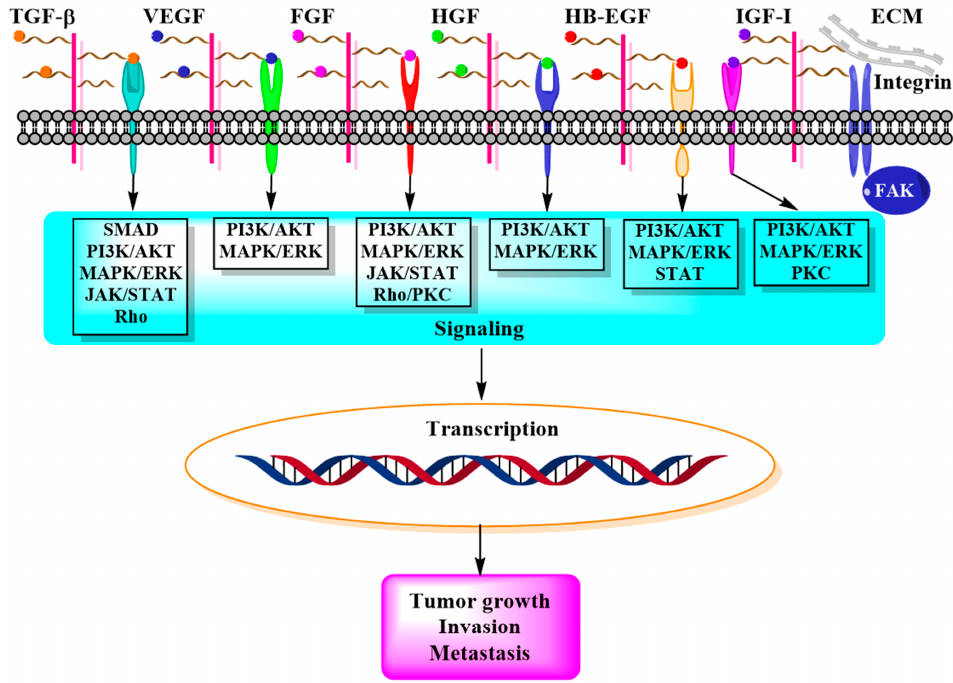
Figure 2. Schematic representation of the interaction between HSPGs, growth factors, and receptors, and main downstream signaling pathways that lead to tumor development and progression.